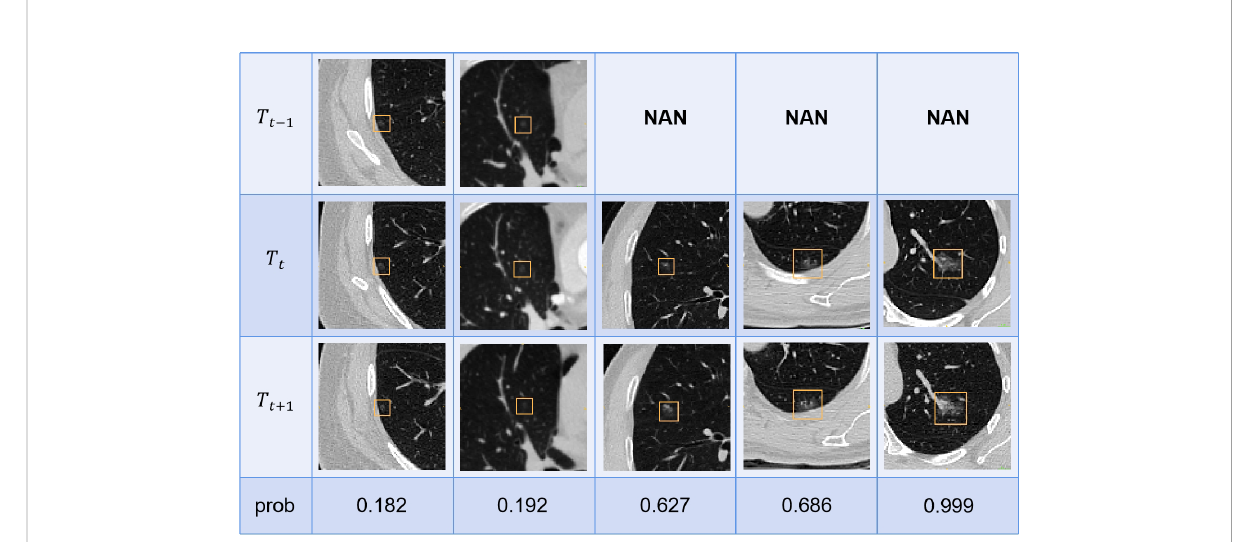
FIGURE 7 Examples of predicting the growth probability by our method in the external test